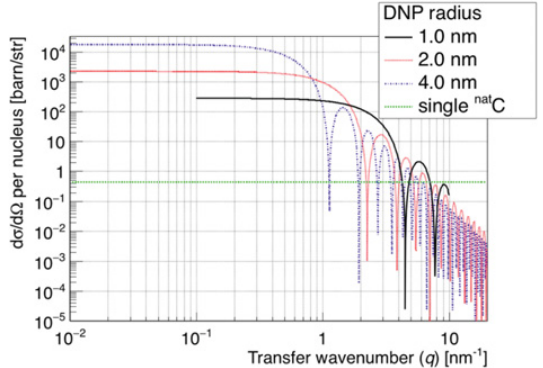
Figure 1. Theoretical q dependences of differential cross sections of DNPs for three particle radii indicated in the legend. The green line shows the scattering cross section of a single carbon nucleus (average for natural isotopic composition). Table 1. DNP specifications